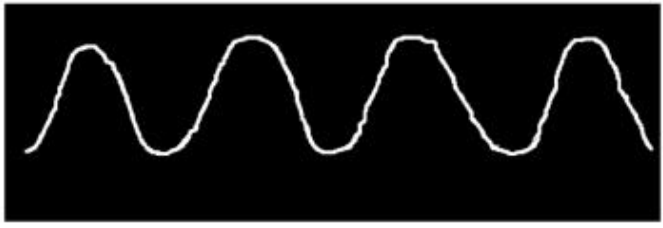
Figure 8. Results of image processing with the infill , skel , dilate operators